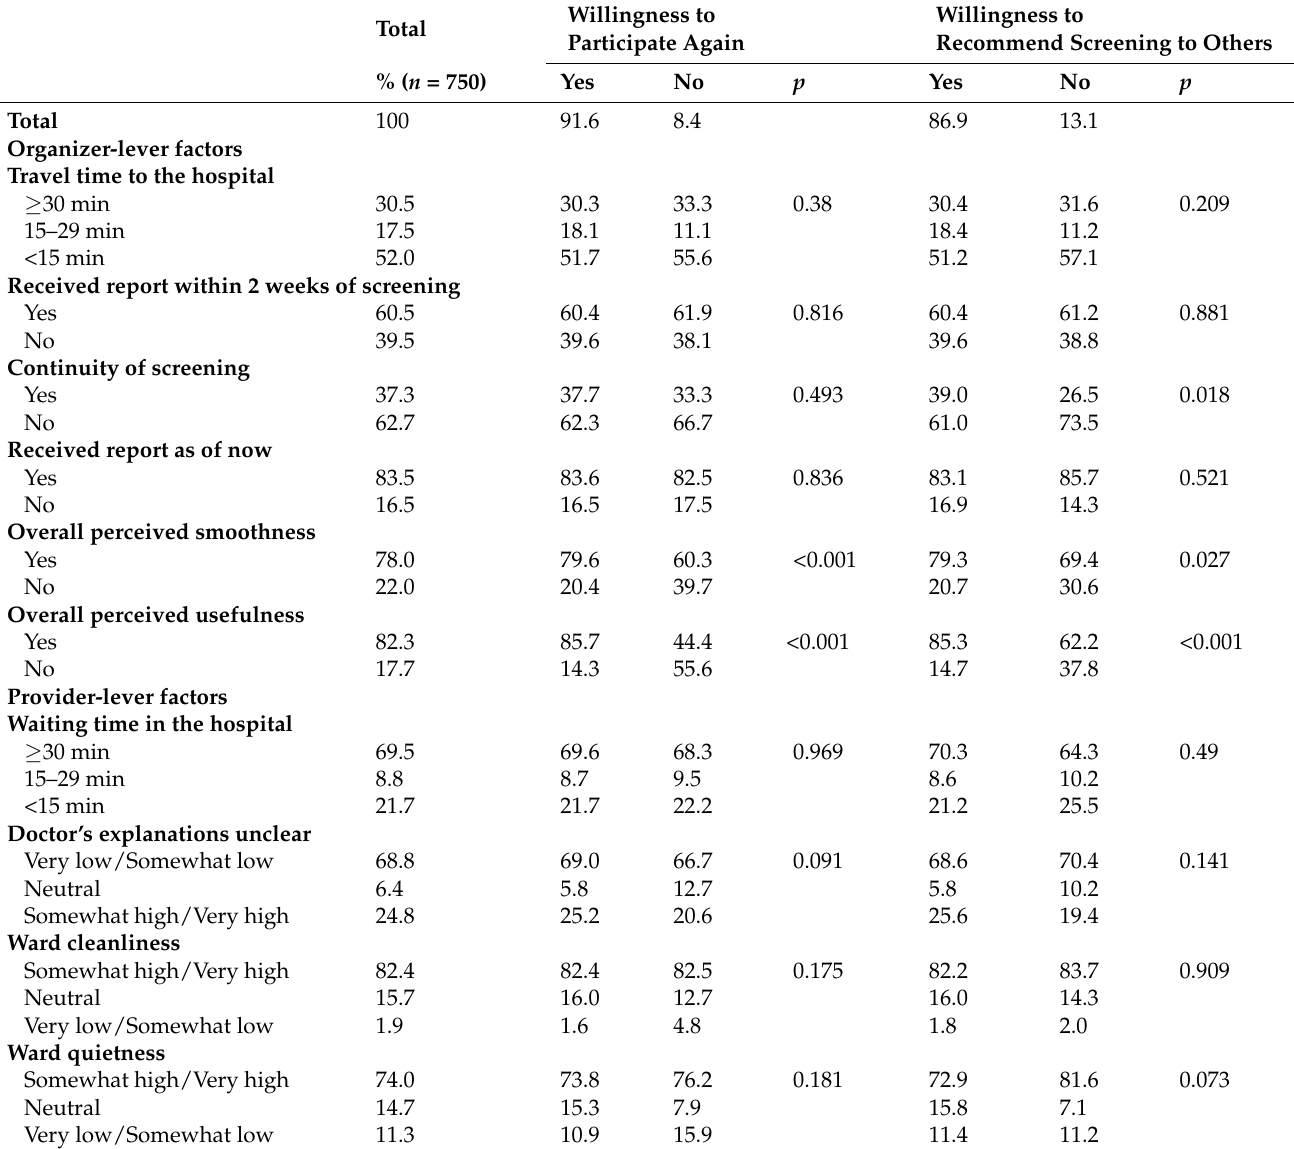
Table 3. The willingness to participate again and to recommend screening to others of organized breast and cervical cancer screening in rural China 2018–2019. Willingness to Total Participate Again